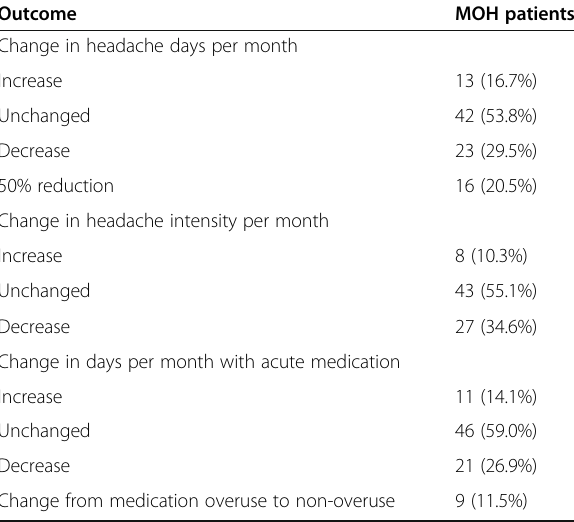
Table 2 Outcome changes during COVID-19 pandemic in MOH patients